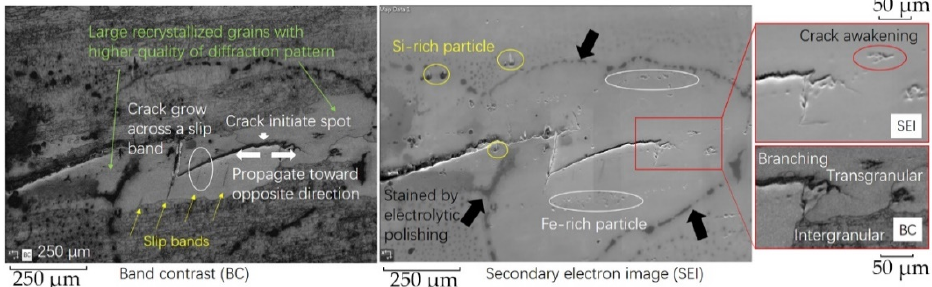
Figure 7. BC (band contrast) map and SEI (secondary electron image) at the crack tip on the base metal.